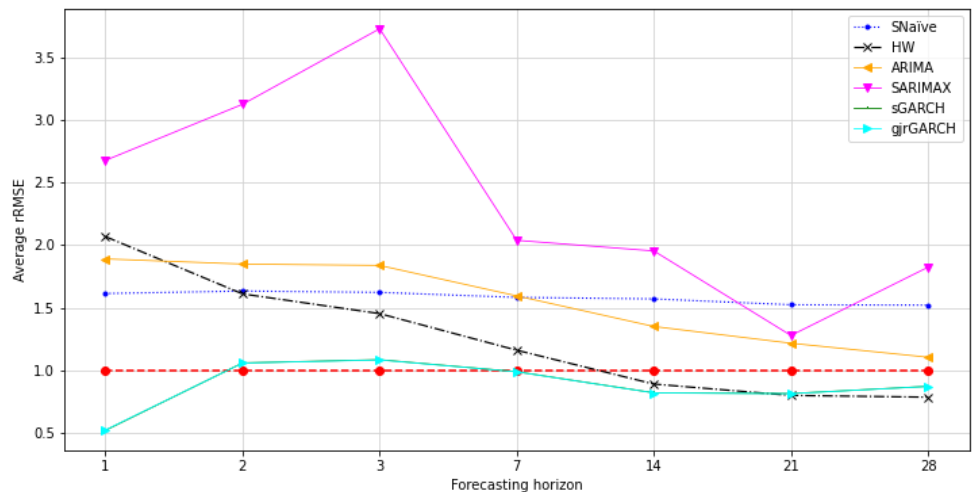
Figure 6. Average rRMSE of Forecasting